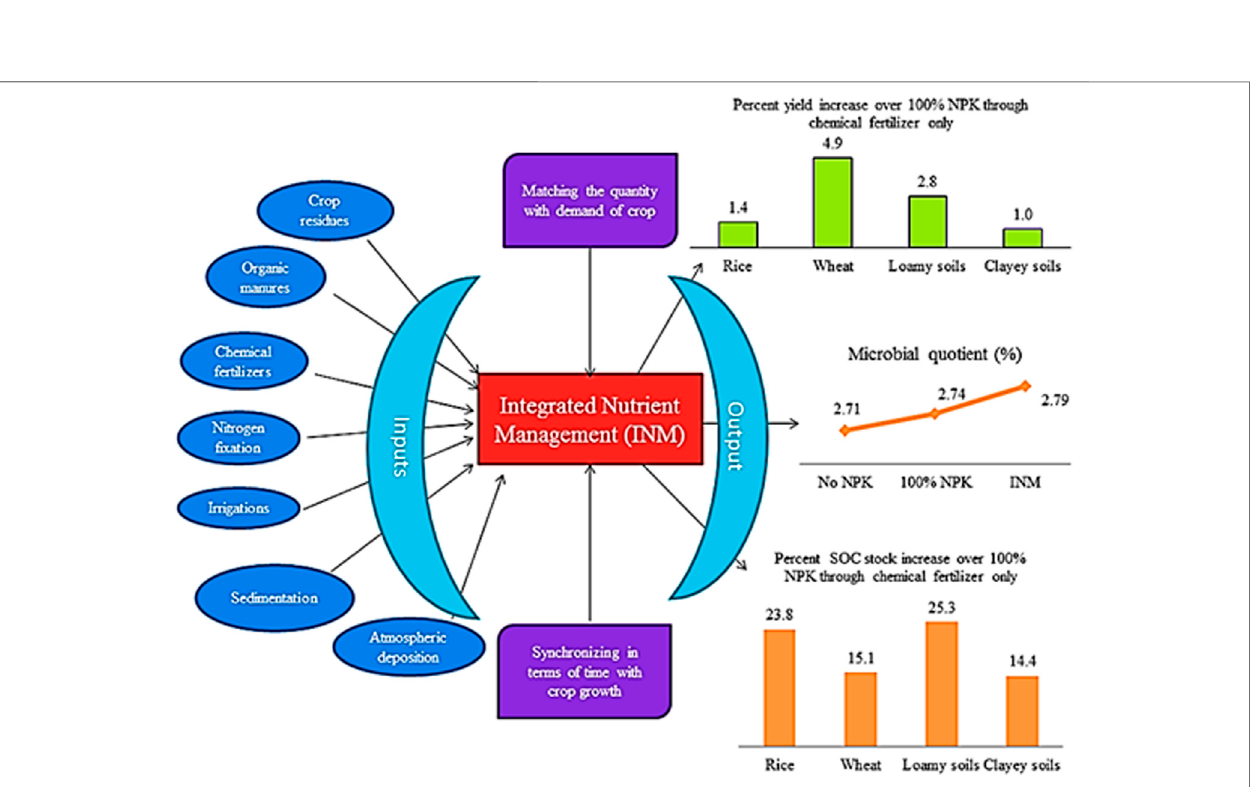
FIGURE 4 | Graphical illustration depicts the performance of INM over no NPK and NPK in crops (rice and wheat) and soil types (loamy and clayey).